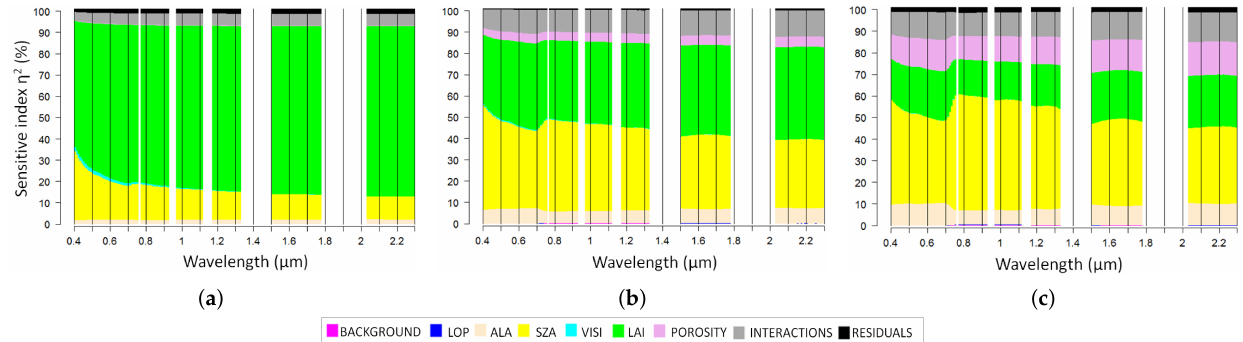
Figure 5. Sensitive index η 2 computed for each input parameter alone or in interactions (contribution in the variability of the output, that is the tree crown transmittance) for different LAI ranges, ( a ) low: 0.5 m 2 .m − 2 ≤ LAI ≤ 2 m 2 .m − 2 , ( b ) medium: Figure 2. This is a wide figure.